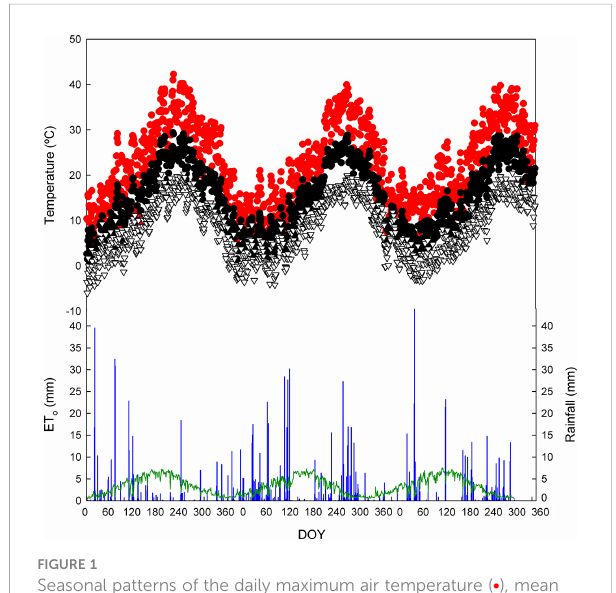
FIGURE 1 Seasonal patterns of the daily maximum air temperature ( (cid:129) ), mean temperature ( (cid:129) ), and minimum temperature ( ▽ ) in Requena, Valencia, Spain. Rainfall is represented with blue bars and reference evapotranspiration (ET o ) with a green line. DOY, day of the